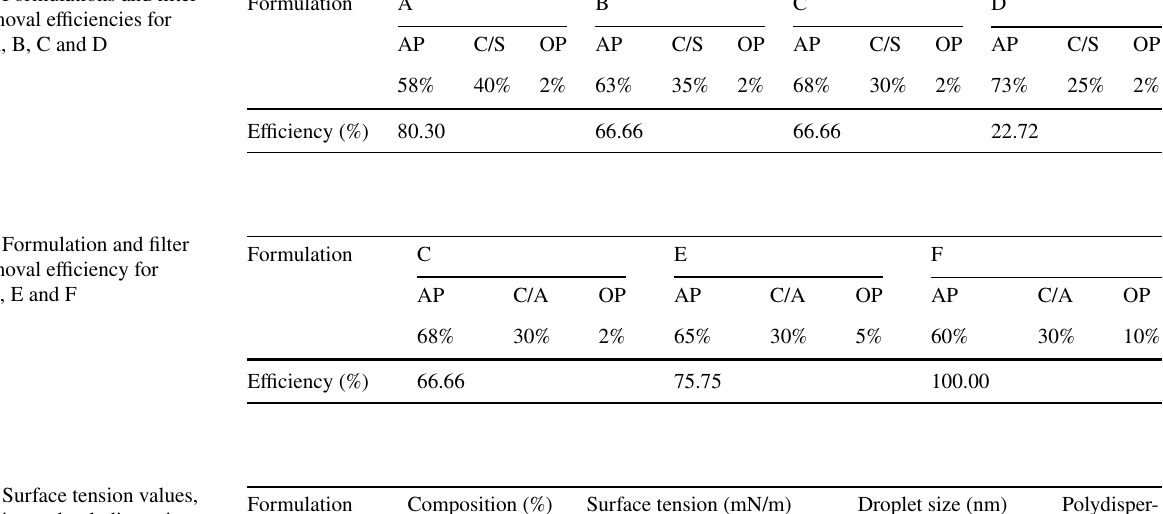
Table 4 Surface tension values, droplet size and polydispersion index